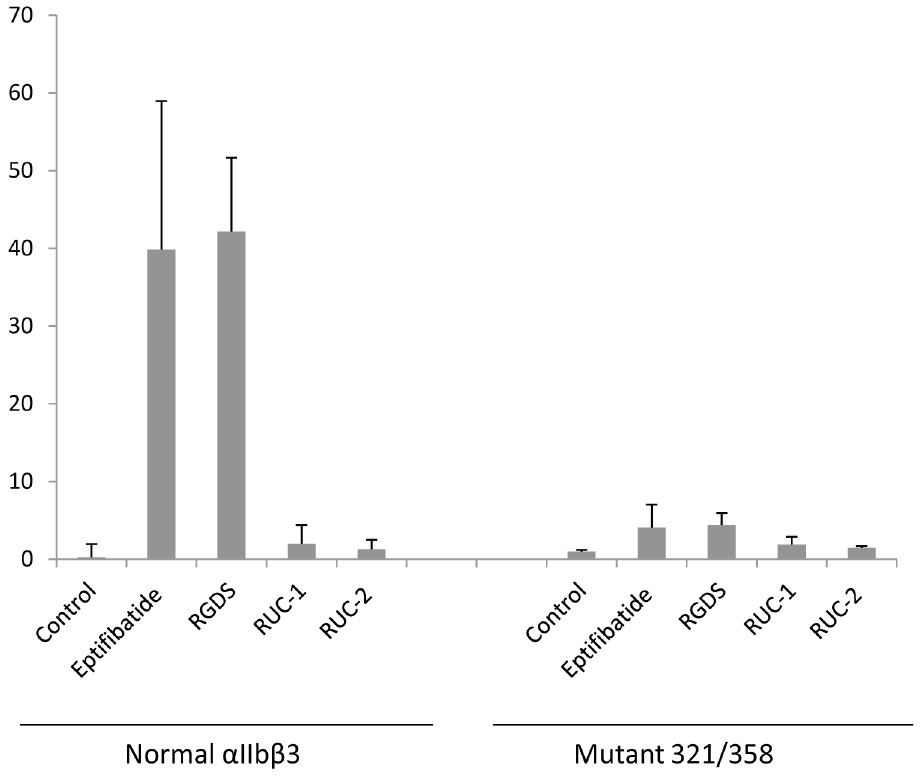
Figure 7. Fibrinogen binding of mutant 321/358 after priming. HEK293 cells expressing normal a IIb b 3 or mutant 321/358 were incubated with buffer (Control), eptifibatide (1 m M), RGDS (100 m M), RUC-1 (100 m M), RUC-2, (1 m M), or EDTA (10 mM) for 20 min at RT and then fixed and washed 4 times. Binding of Alexa488-conjugated fibrinogen (200 m g/ml) was then assessed by flow cytometry and expressed as NNFI, in which the net geometric mean fluorescence intensity after subtracting the background is divided by the relative surface receptor expression as judged by the binding of mAb 10E5. Data expressed as mean 6 SD after subtracting the EDTA value as background (n=3). doi:10.1371/journal.pone.0081609.g007 PLOS ONE |